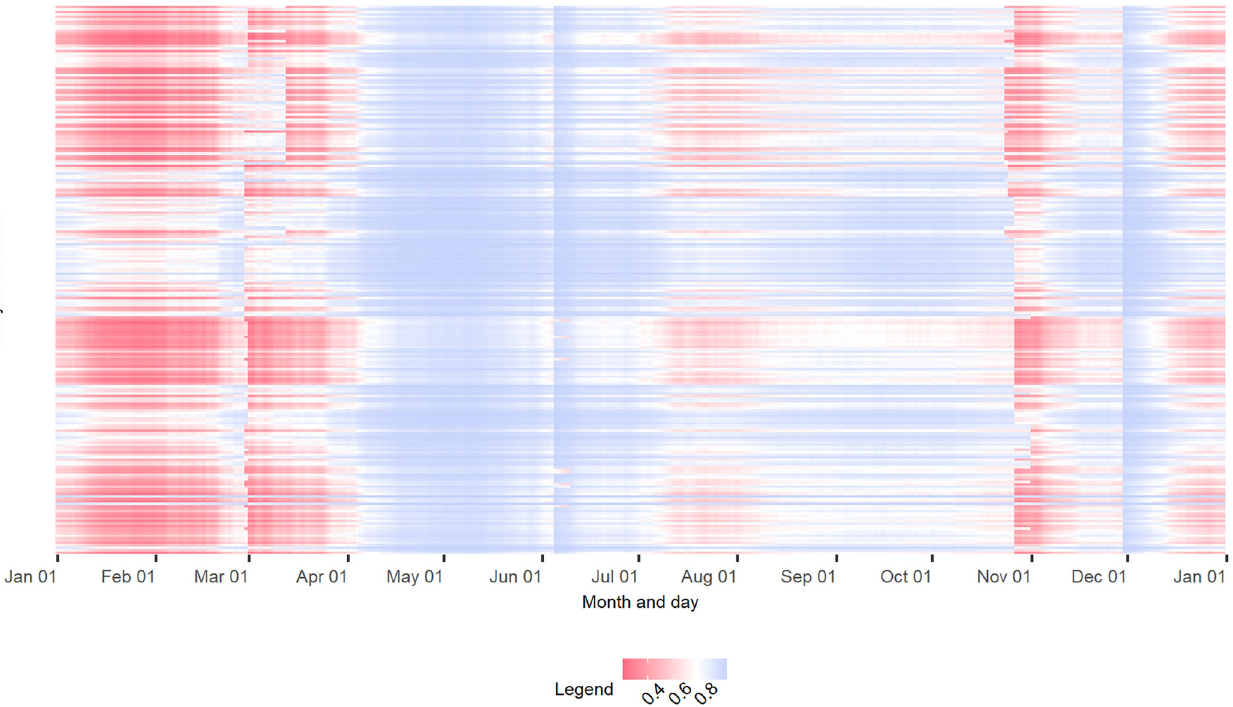
Fig. 5 Heat map of predicted availability of rainwater stored at home. Each column represents a day (of a year), and each row represents one of the 224 study households. Predicted probability of having stored rainwater was scaled from red (NOT AVAILABLE: smaller than the optimal cutoff value of 0.767 (in white), selected by maximising the sum of sensitivity and speci fi city) to blue (AVAILABLE: greater than 0.767)